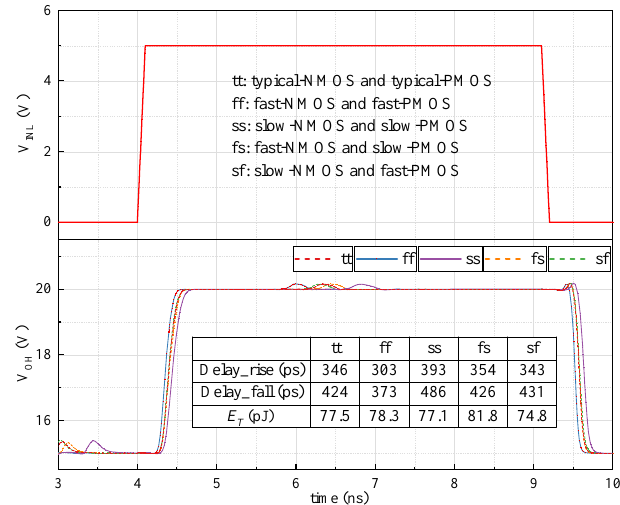
Figure 11. Simulations on the propagation delay and E T at different process corners.